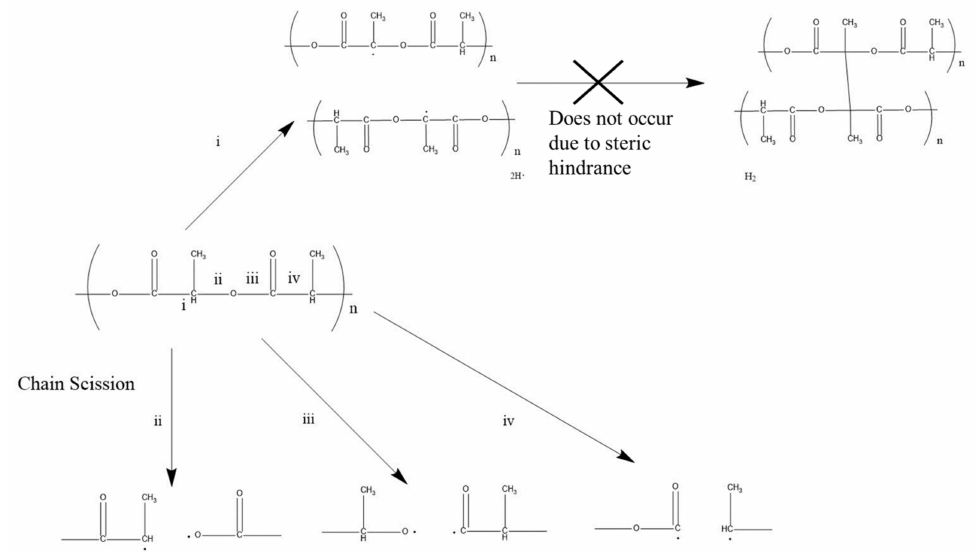
Figure 4. Proposed mechanism for chain scission of PLA after electron beam